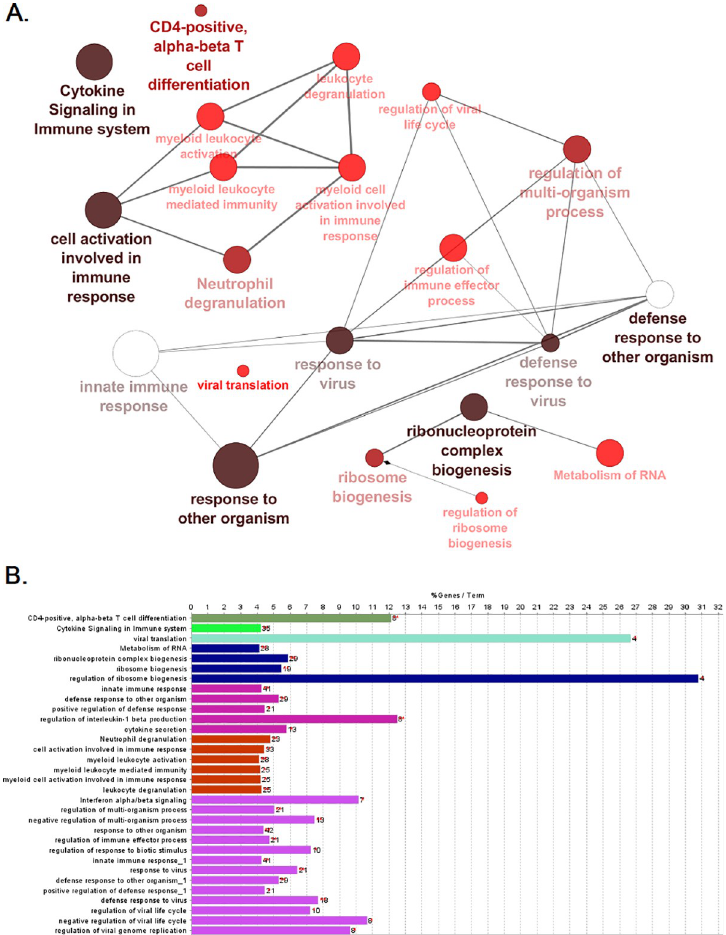
Fig 4. Over-represented biological pathways and gene ontology terms. Gene ontology and pathway enrichment analysis were conducted using the ClueGO plugin in Cytoscape. A the most significant terms where the node size correlates to the term enrichment significance. Pathways related to innate immunity activation and pathogen defense mechanisms appear as the most significant terms in our analysis. B the same most highly enriched terms shown as bars, where the bars represent the number of genes associated to this term, and the percentage of genes per term is shown as bar label.